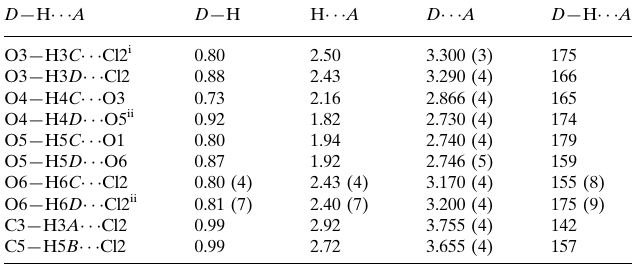
Hydrogen-bond geometry (A˚ , (cid:3)